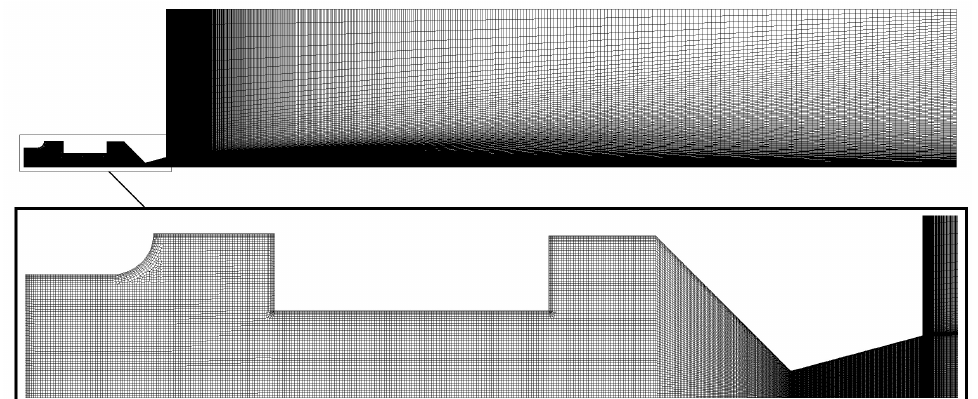
Figure 7. Complete mesh, with zoom on the motor region.